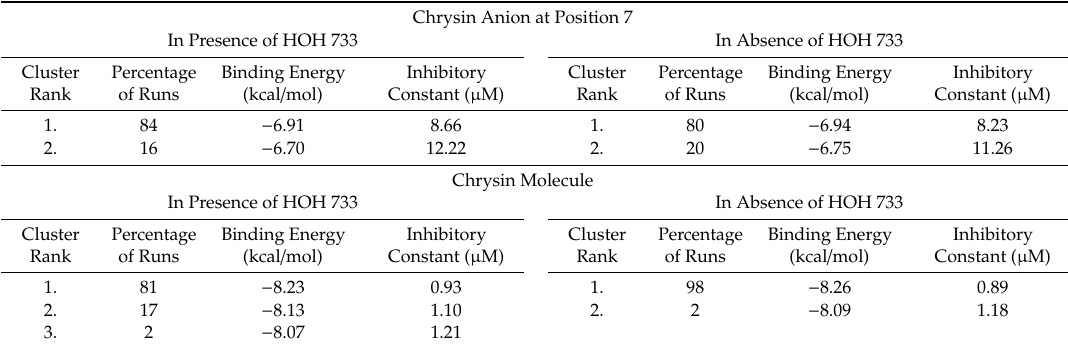
Figure 7. Comparison of docked chrysin species in presence and in absence of the HOH 733 water molecule (the results are identical in both cases). Anion species are depicted in blue (top-ranked docked species) and pink (second top-ranked docked species), while molecule species are depicted in green (top-ranked molecule species) and orange (third top-ranked molecule species in presence of HOH 733 and second top-ranked molecule species in absence of HOH 733). Oxygen atoms are depicted in red, nitrogen atoms in blue, hydrogen atoms in white, and heme iron in orange. Table 1. Summary of Chrysin Species Docking.